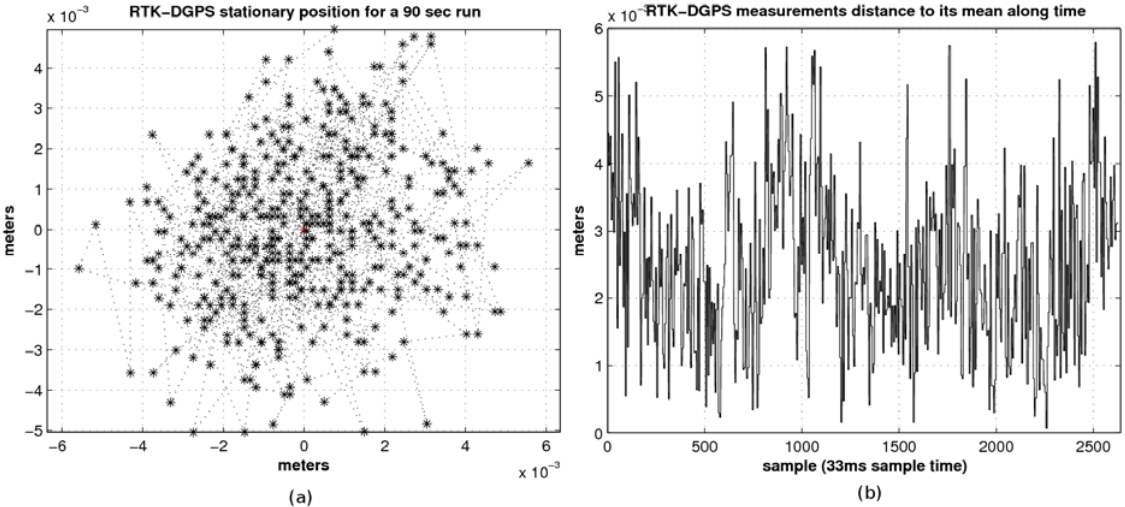
Figure 11. (a) RTK-DGPS stationary position in a 90 s run. (b) RTK-DGPS distance to its